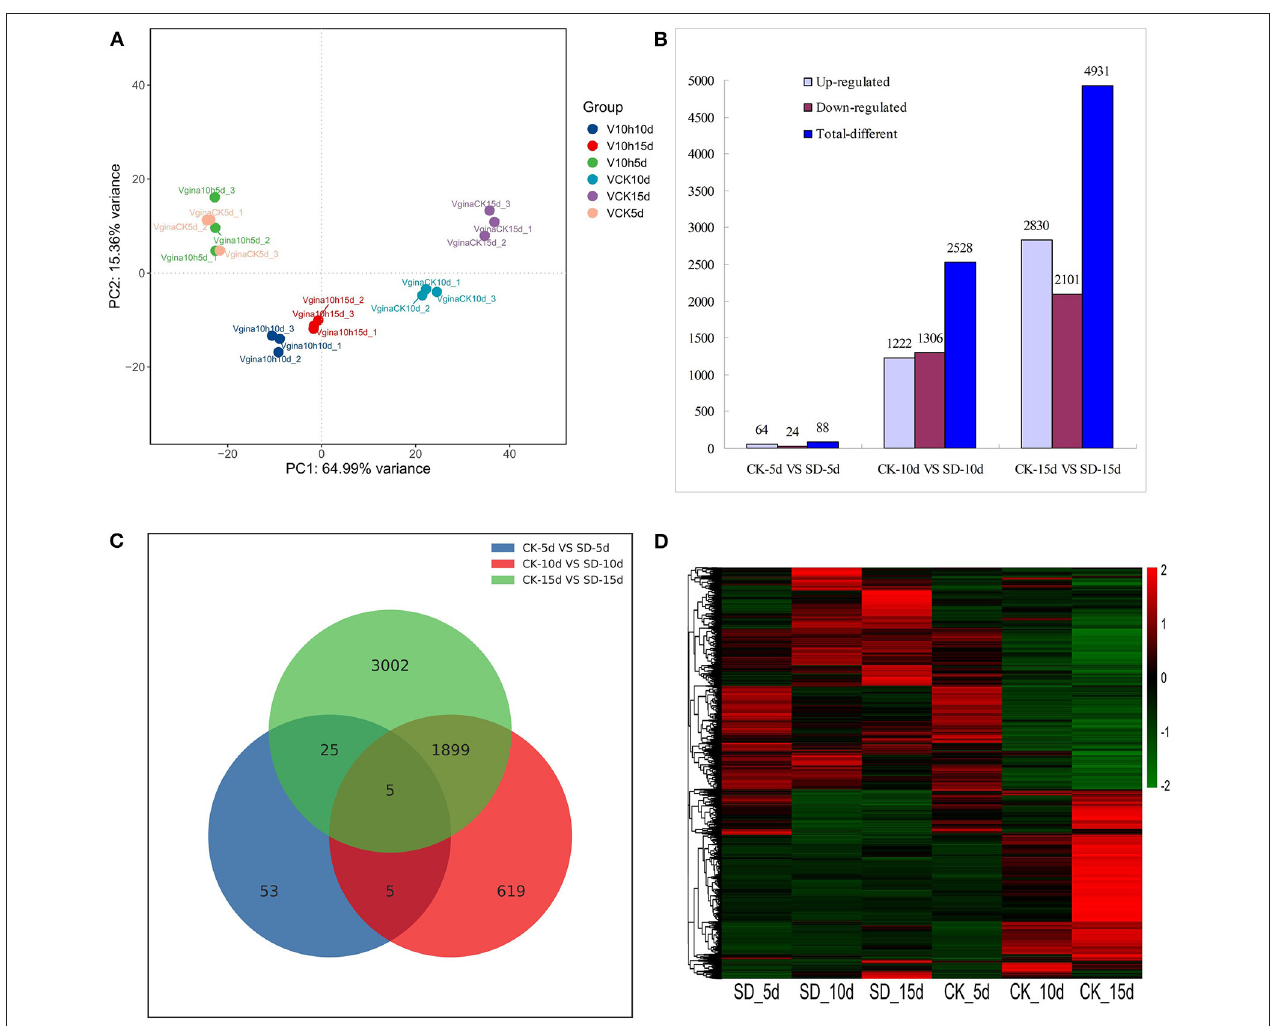
FIGURE 2 | Analysis of differentially expressed genes in response to short-day photoperiod. (A) Principal component analysis of the sequenced samples. (B) Numbers of the significantly regulated genes under different days short-day photoperiod treatment. The numbers on the horizontal axis reflect different treatment and the vertical axis represents numbers of total, up-and down-regulated genes, respectively. (C) Venn diagram analysis of significantly regulated genes under different days short-day photoperiod treatment. (D) Heatmap clustering of global pattern of the strongly regulated genes conducted using Hierarchical Clustering (HCL) algorithm under different days short-day photoperiod treatment. The color scale represents the values of lg FPKM (FPKM–Fragments Per Kilobase of transcript per Million fragments